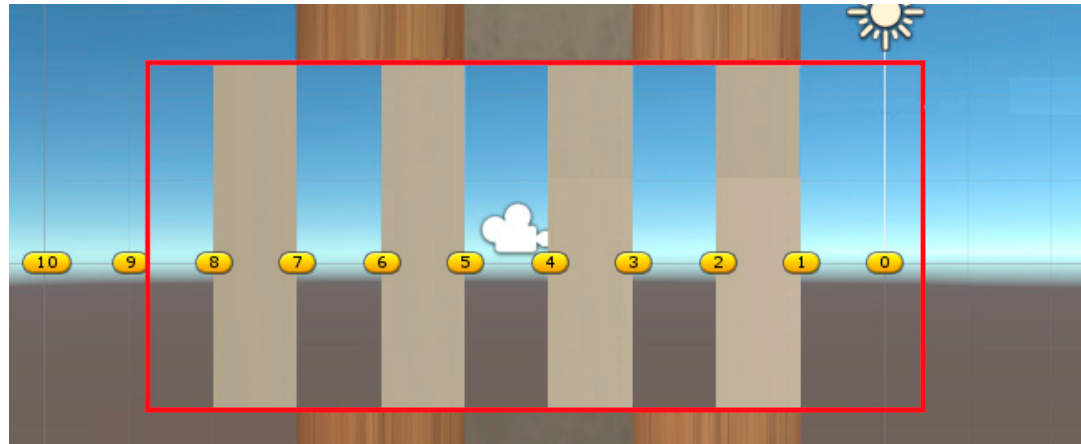
Figure 3. Spring–mass layered model for the Falcon haptic device.